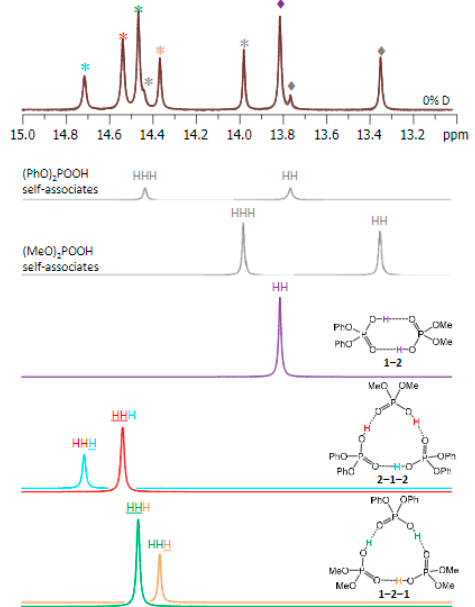
Figure 12. High-frequency part of the 1 H NMR spectrum of partially deuterated (OH/OD, 57%D) of a mixture of diphenylphosphoric and dimethylphospinic acid in CDF 3 /CDF 2 Cl at 100 K. Trimers are marked with asterisks and dimers with diamonds. Reprinted from Ref. [32].